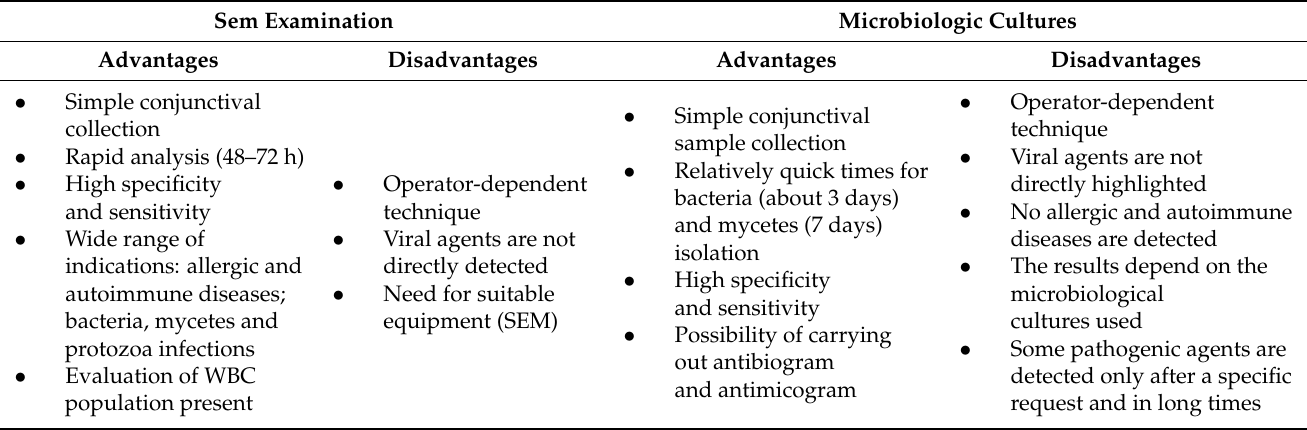
Table 2. Advantages and limitations of SEM examination and Microbiologic standard